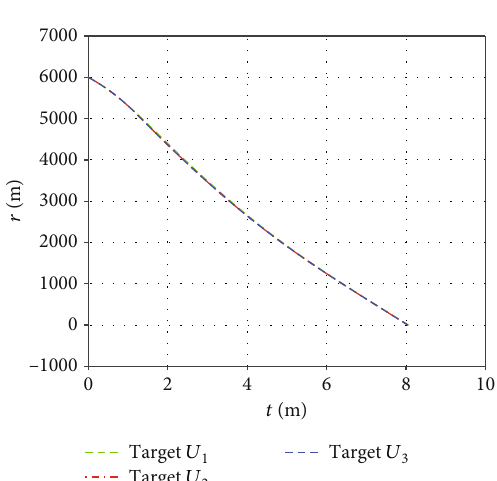
Figure 4: Ranges between the missile and the target.